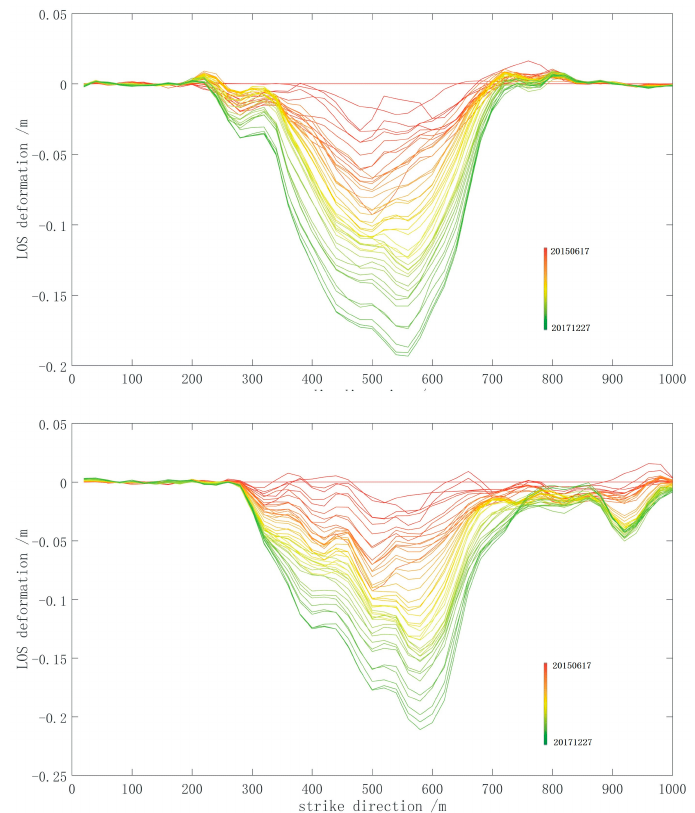
Fig 9 Figure 9. Profiles of the coal mine in a time series. The upper and lower profiles show the LOS deformation of the coal mine in the strike and dip directions, respectively. From the red to green lines, the subsidence increased gradually during the observation period. During mining, the subsidence center changed with mining and the scope of the collapse basin are different in the two